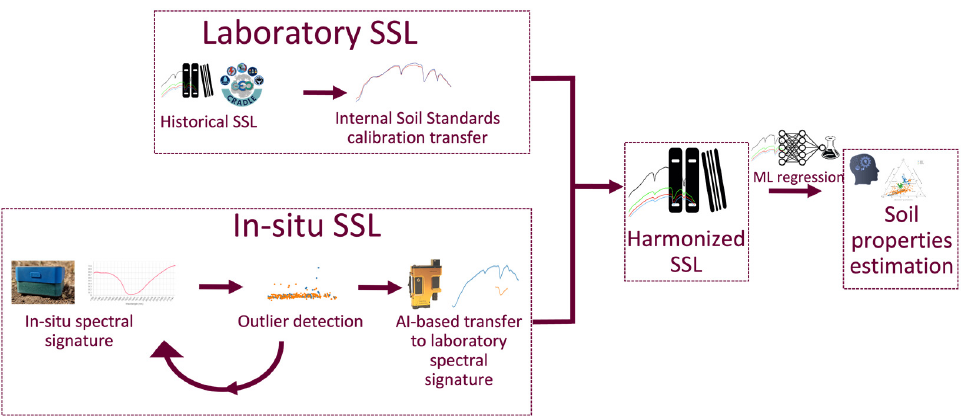
Figure 1. Methodological flow for the soil properties estimation based on in-situ spectral signatures.